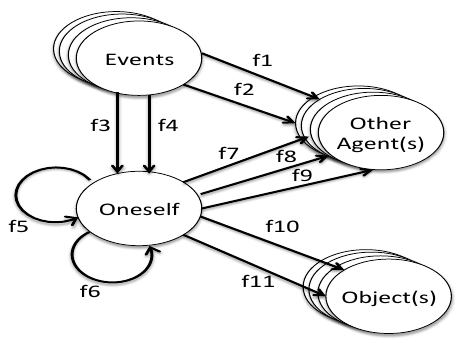
Figure 20. A graph of the emotion relation according to the OCC model.